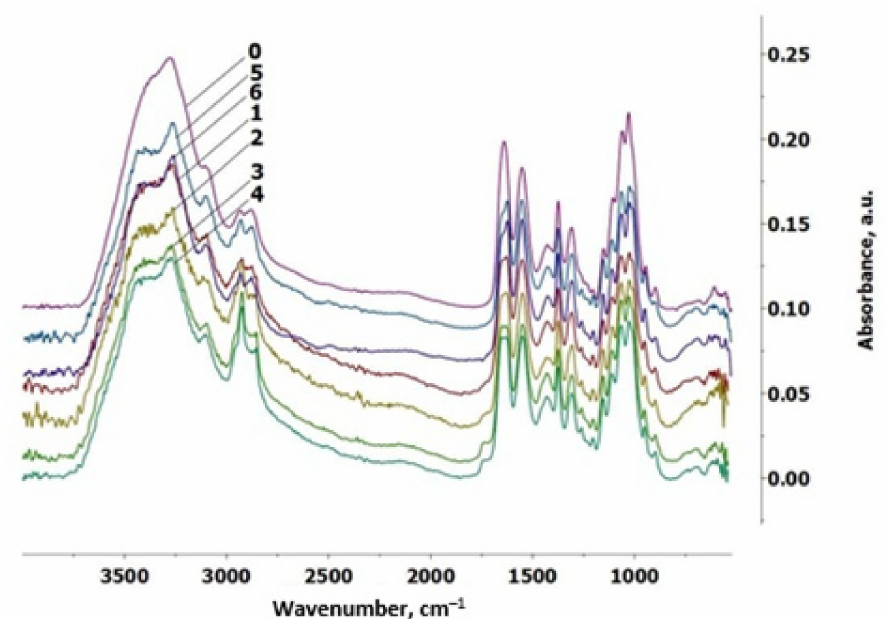
Figure 3. FTIR spectra of chitin and chitin cryogels; 0 = original chitin, 1–6 = samples of chitin cryogels according to Table